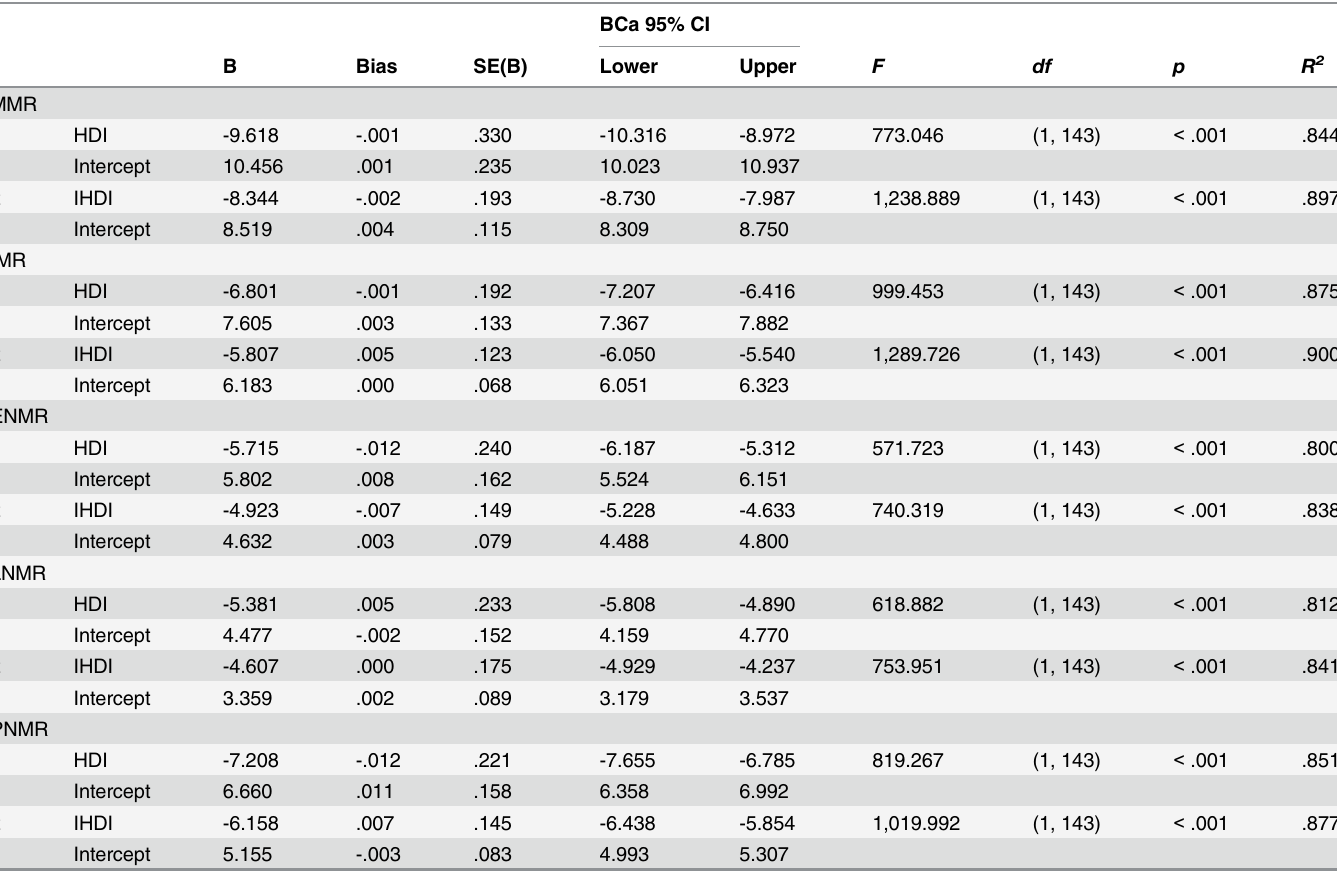
Table 2. Simple OLS Regression Models for MMR, IMR, ENMR, LNMR, and PNMR on HDI and